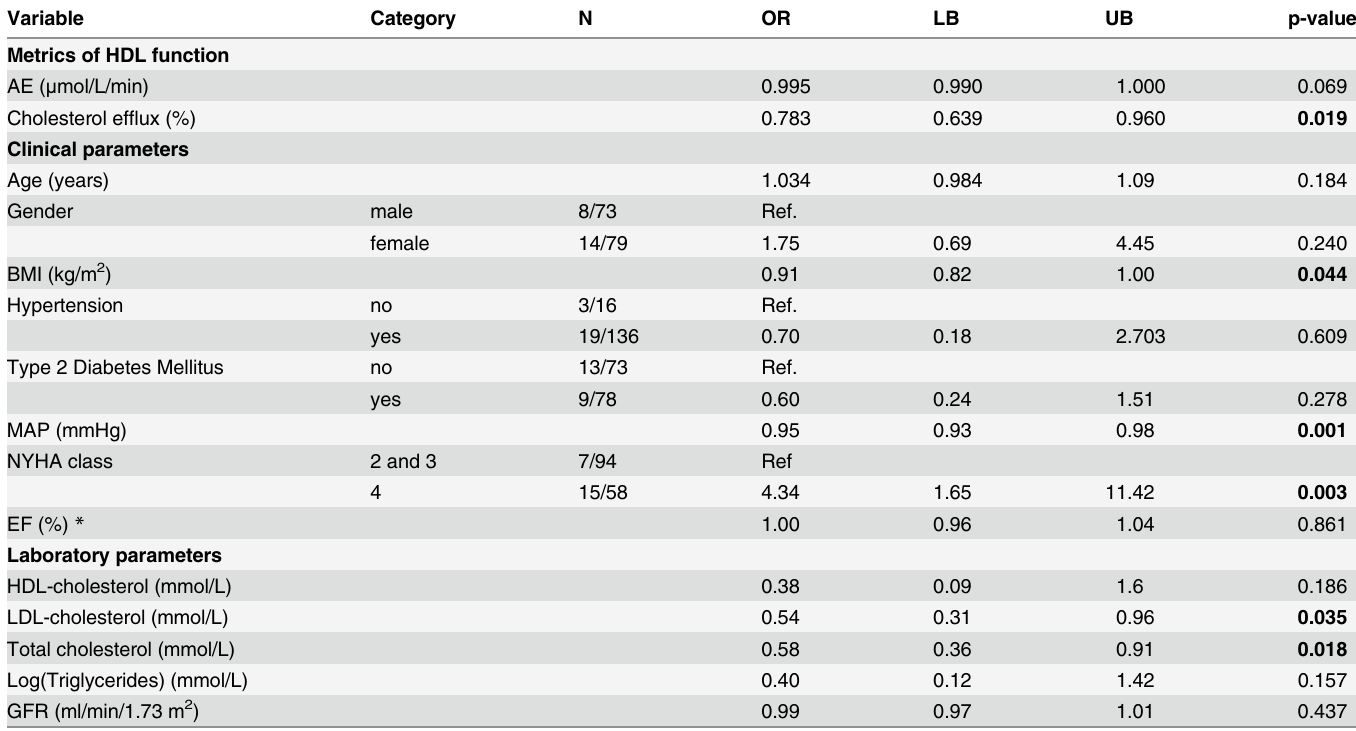
Table 3. Univariable logistic regression analysis of HDL function, clinical and laboratory parameters and hospital mortality. Variable